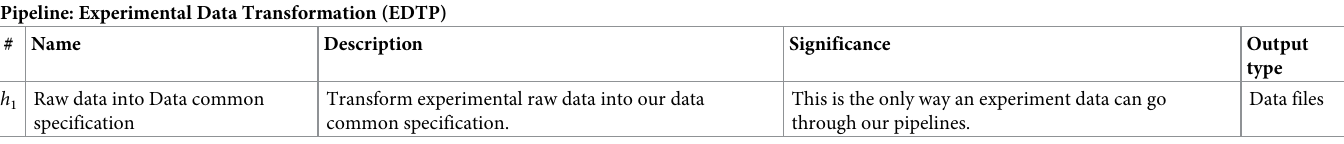
Table 9. Listing of types of functions as microservices for the (1) Experimental Data Transformation Pipeline (EDTP). Pipeline: Experimental Data Transformation